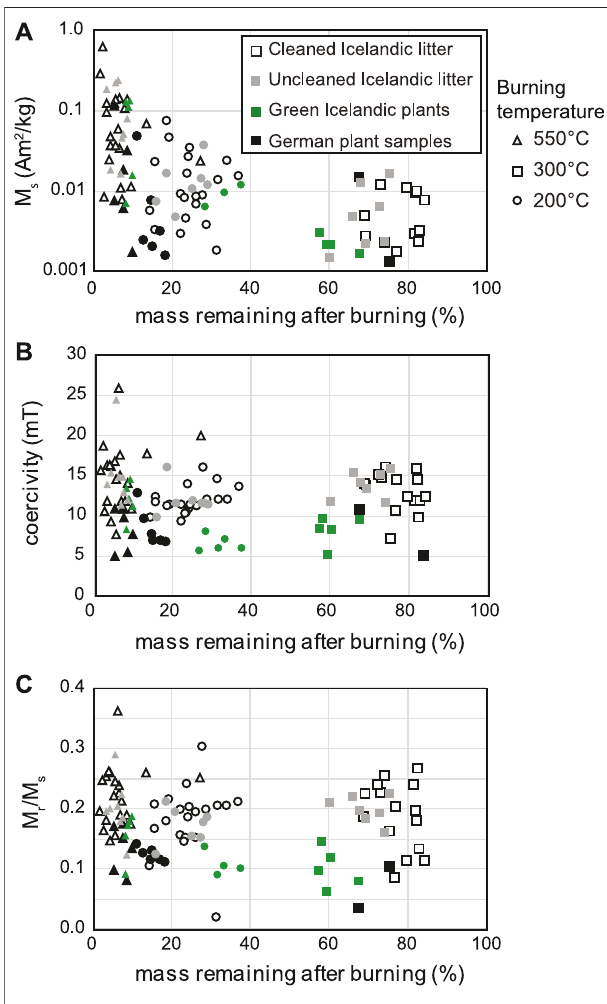
FIGURE 9 | (A) Concentrations of Fe plotted against Al and Ti in Icelandic plant ash samples determined by wet digestion. (B) Comparison of TicontentwithsaturationmagnetizationbasedontheashedmassofIcelandic plants. Error bars are based on relative standard deviation among analyticalreplicates. Datashown areforsamplescombusted at550 ° Cfor4 h. RedsymbolsinArepresentmeanelementalconcentrationsinvariousformsof biomass reported by Vassilev et al. (2010).